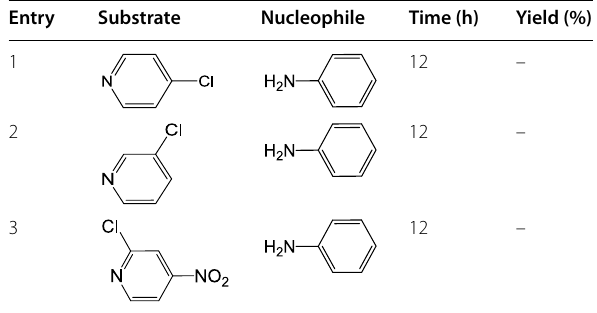
Table 3 Scope in pyridine analogues for nucleophilic aro- matic substitution